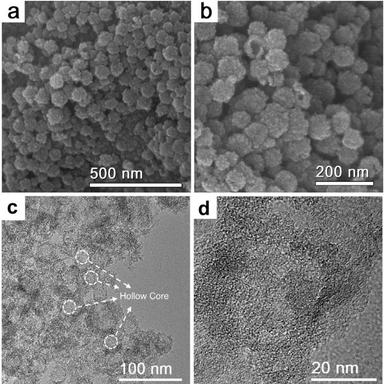
(a and b) SEM images of NNSC-1. (c and d) TEM images of NNSC-1.